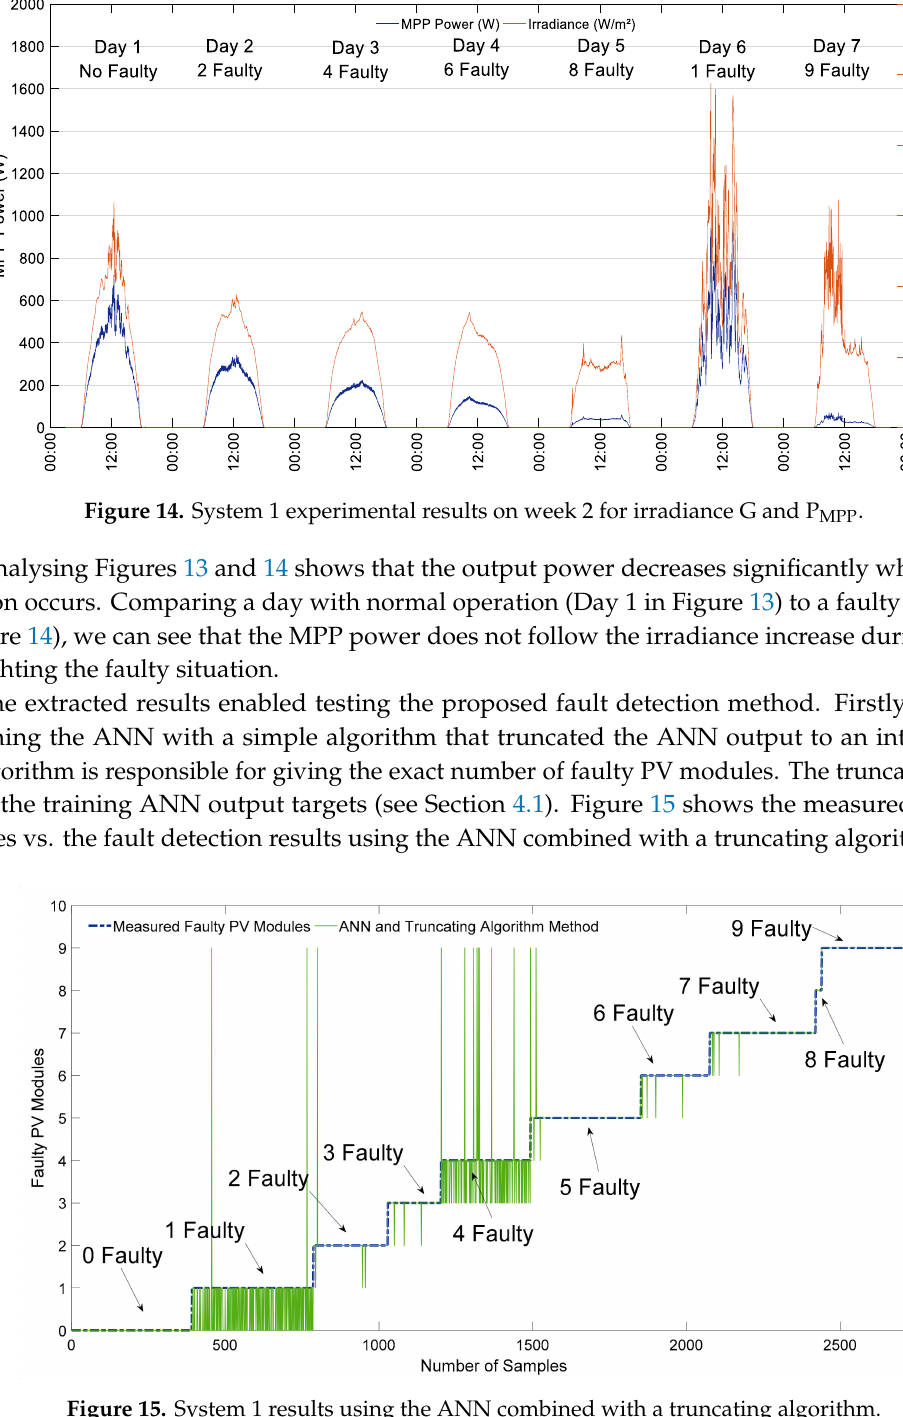
Figure 13. System 1 experimental results on week 1 for irradiance G and P MPP.